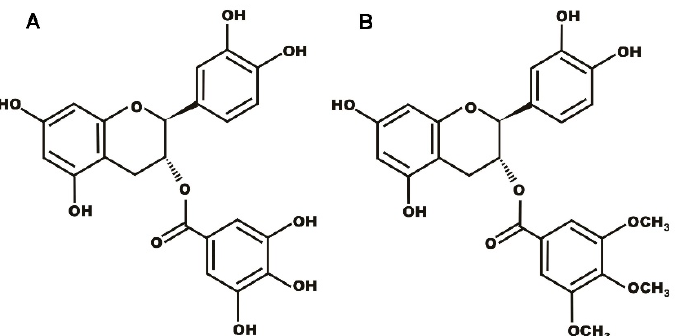
Figure 1. Chemical structure of ( A ) catechin gallate and ( B ) 3,4,5-trimethoxybenzoate of catechin (TMBC).